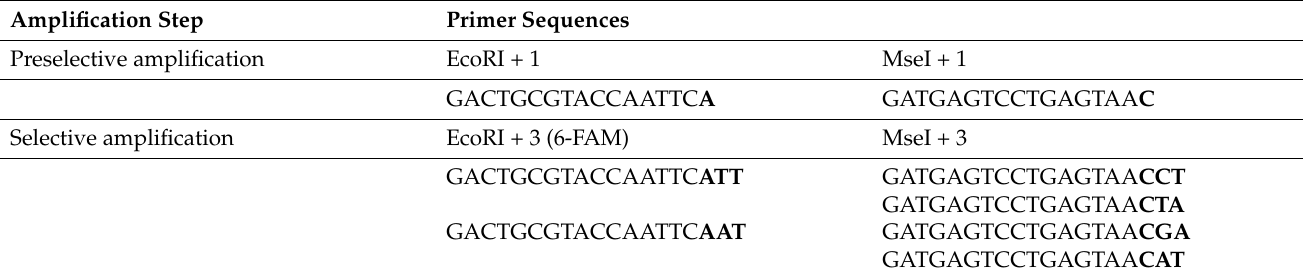
Table 11. Preselective and selective primers used for AFLP analysis (selective nucleotides are shown in